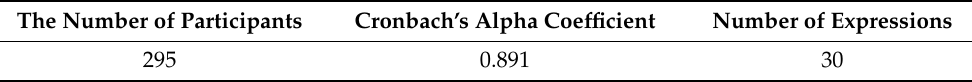
Table 1. Test results.